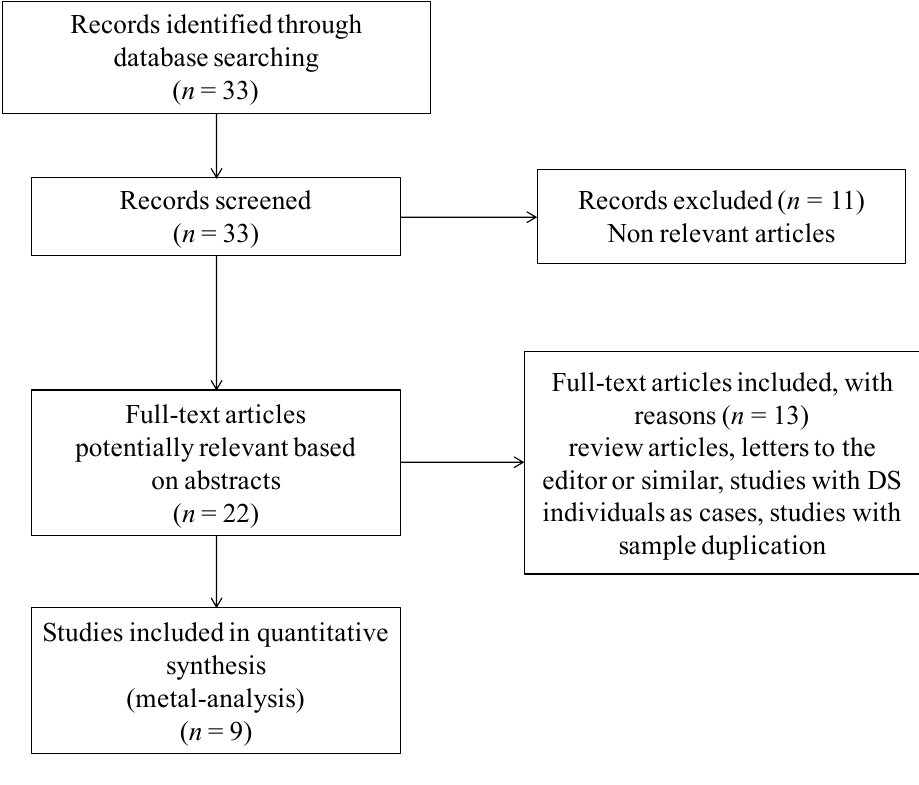
Figure 1. Flow chart of retrieved studies and studies excluded, with reasons